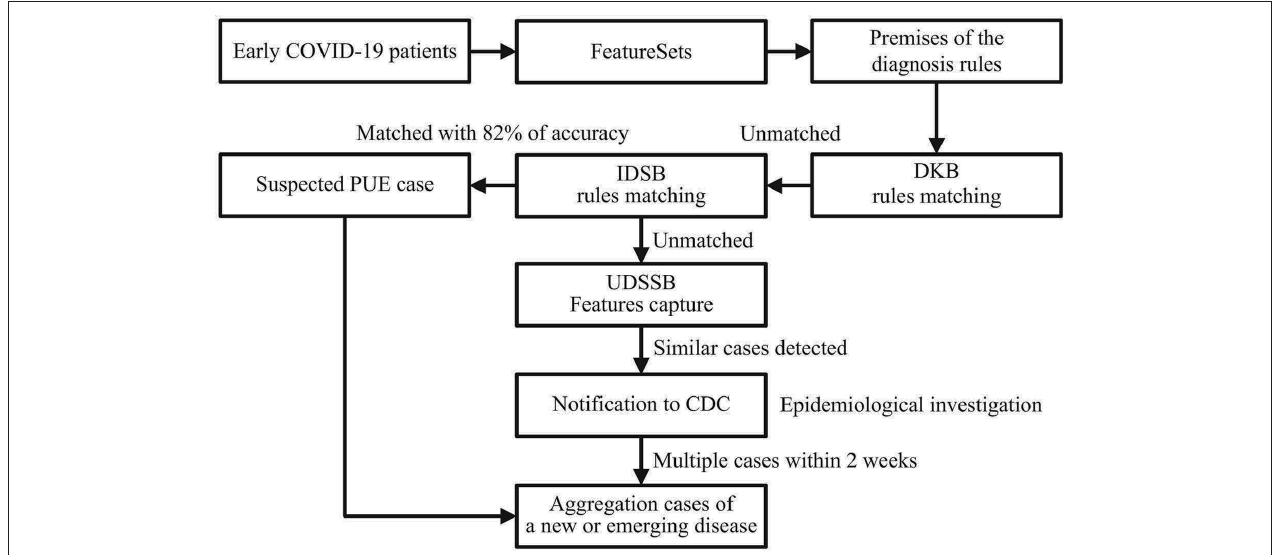
FIGURE 2 | Detection process schematic diagram of the early COVID-19 cases in Wuhan, China; DKB, Diagnosis Knowledge Base; IDSB, Infectious Diseases Surveillance Base; PUE, Pneumonia with Uncertain Etiologies; UDSSB, Unknown Diseases Syndromic Surveillance Base; CDC, Centers for Disease Control and